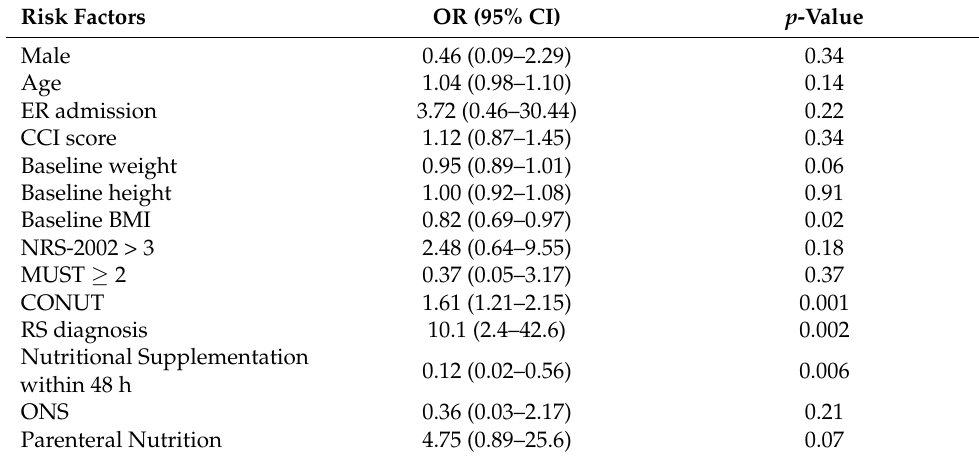
Table 5. Univariate analyses of risk factors associated with in-hospital mortality (n = 9).